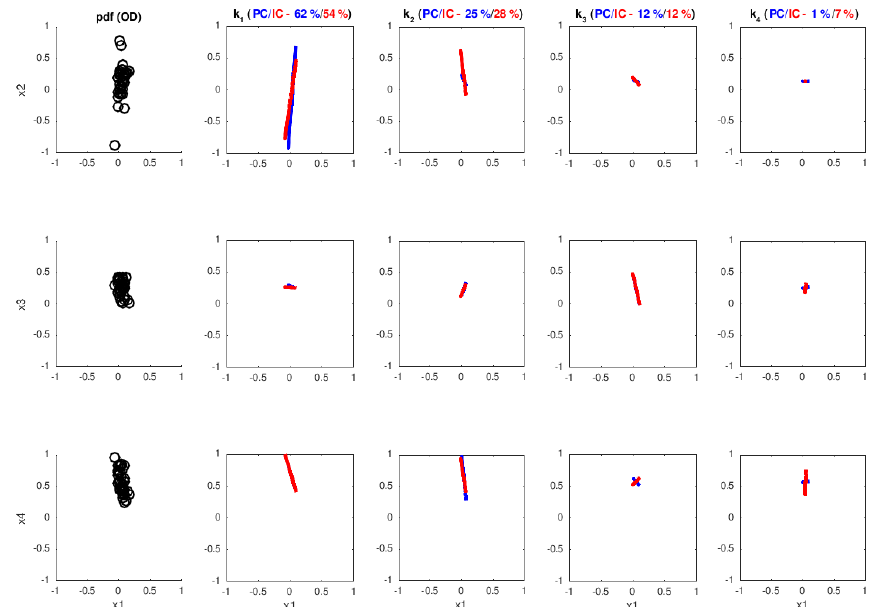
Figure 19. PCA (blue) and ICA (red) applied to the H > 0 . 4 regions of an example of the RHI from the event considered in the inter-radar comparison in Sect. 3.1 (Plaine Morte C-band